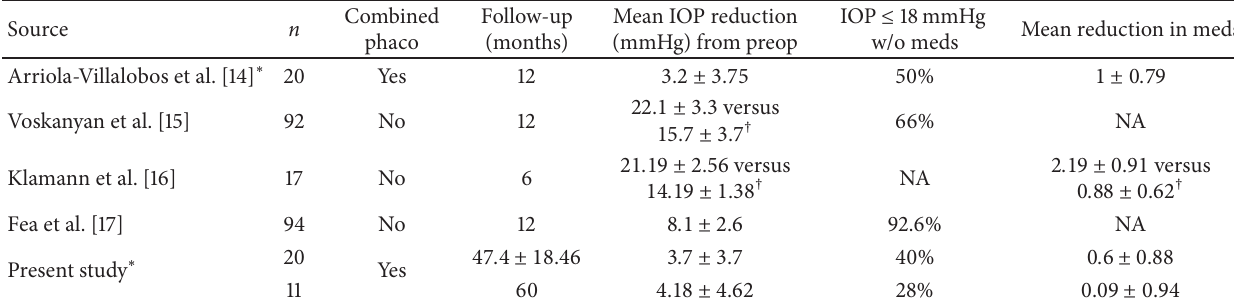
Table 4: Outcome variables reported in the studies that have addressed the efficacy of iStent GTS-400 placement. The data provided for the present study are end-follow-up data for the 20 eyes enrolled and 5-year results for 11 eyes.